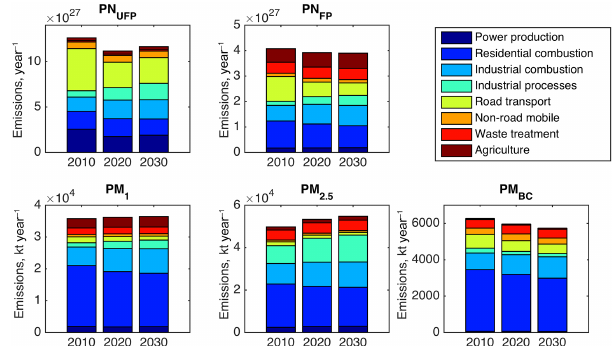
Figure 8. Shares of different source sectors to the future global trends in particle number and mass emissions under current leg- islation scenario: PN emissions in ultrafine and fine size ranges and particle mass emissions PM 1 , PM 2 . 5 and black